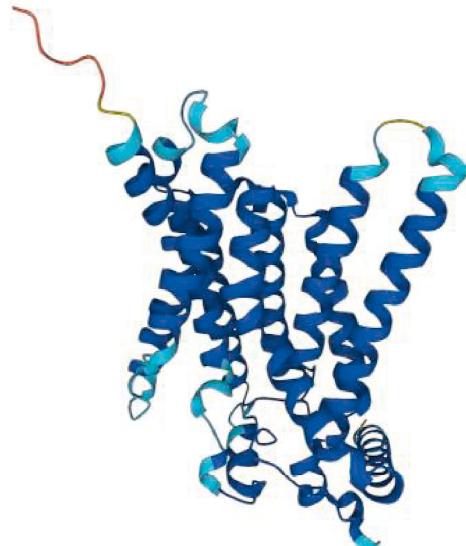
Figure 3: Structure of G6Pase predicted by AlphaFold-2. Dark blue indicates a predicted Local Distance Difference Test (pLDDT) score above 90 and light blue indicates a pLDDTscore of between 70 and